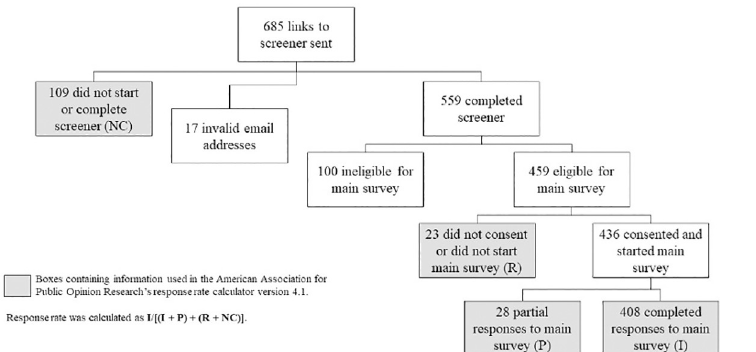
Fig 2. Recruitment flowchart for the entire sample.